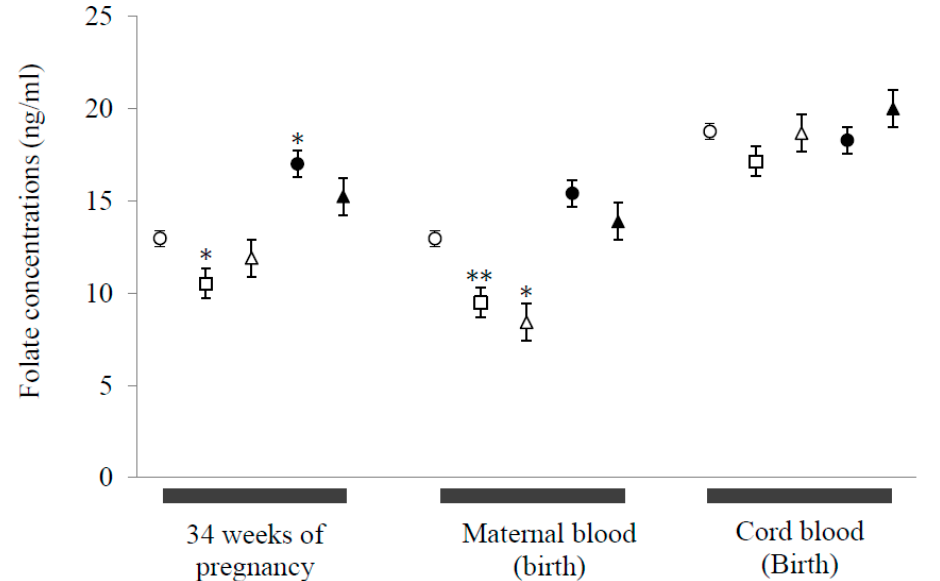
Figure 1. Effects of maternal pre-pregnancy BMI and gestational diabetes on maternal and neonatal folate serum concentrations. Maternal samples were taken at 34 weeks gestation and at term/delivery i.e., c. 39 weeks of pregnancy, neonatal samples were taken from cord blood at birth. Open circles: normal weight (N: maternal, n = 59; cord, n = 33); open squares: overweight (OW: maternal, n = 29; cord, n = 15); open triangles: obese (O: maternal, n = 22; cord, n = 12); closed circles: gestational diabetic, normal weight (GDN: maternal, n = 14; cord, n = 7); closed triangles: gestational diabetic, obese women (GDO: maternal, n = 11; cord, n = 7). Values represent means ± S.E.M. Statistical differences between groups denoted at each time point by *, ** correspond to p < 0.05, p < 0.01 respectively compared to normal weight control group (independent t test for continuous variables).